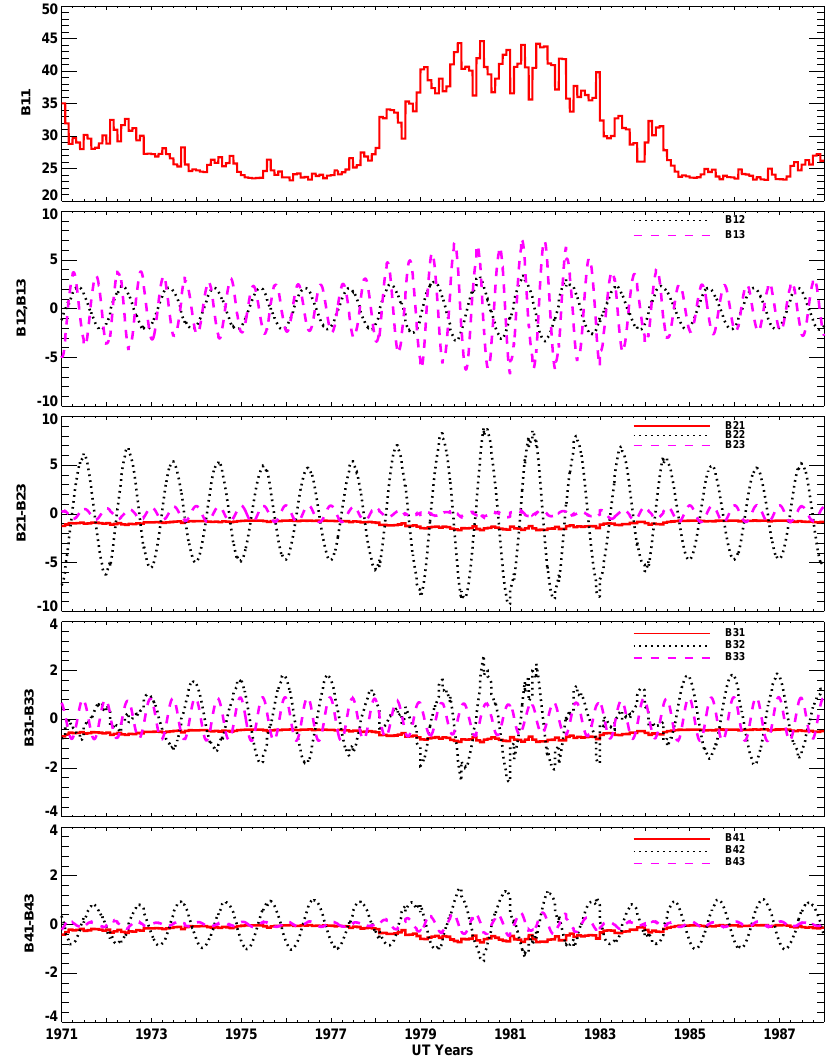
Fig. 5. Variation components of fitted EOF coefficients with different